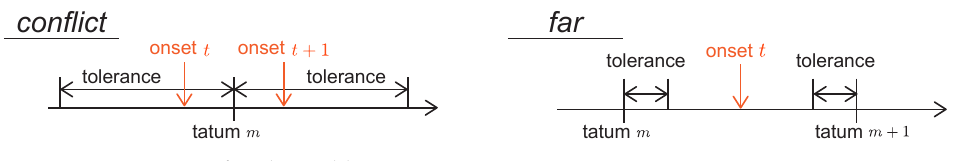
Figure 7. Two groups of undetectable onset times.